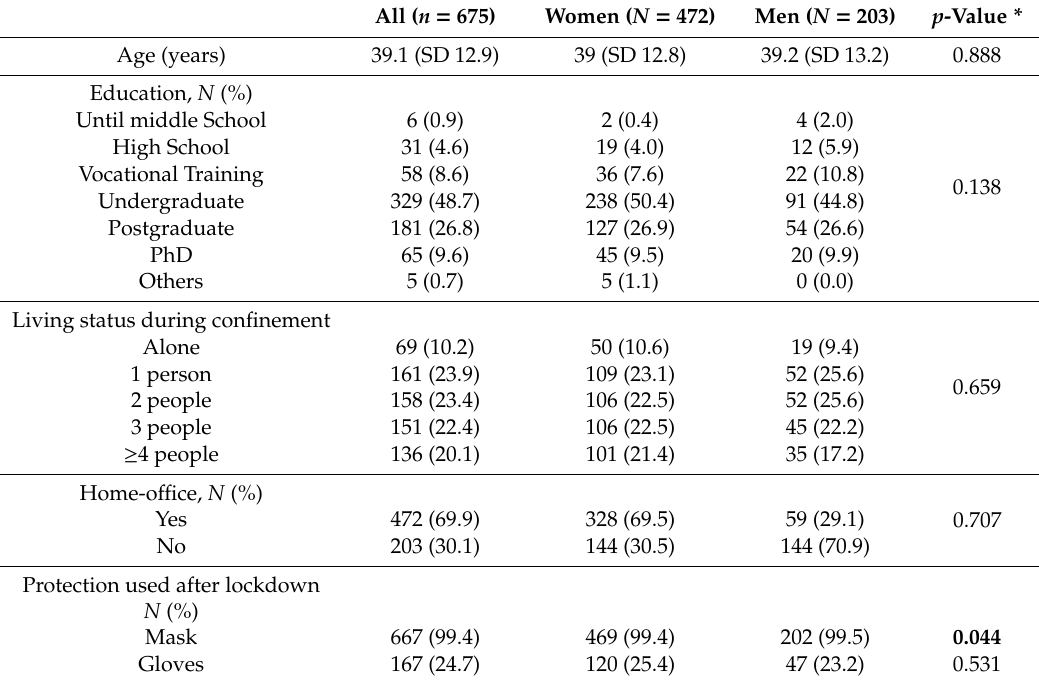
Table 1. General characteristics and demographics of the participants enrolled in the